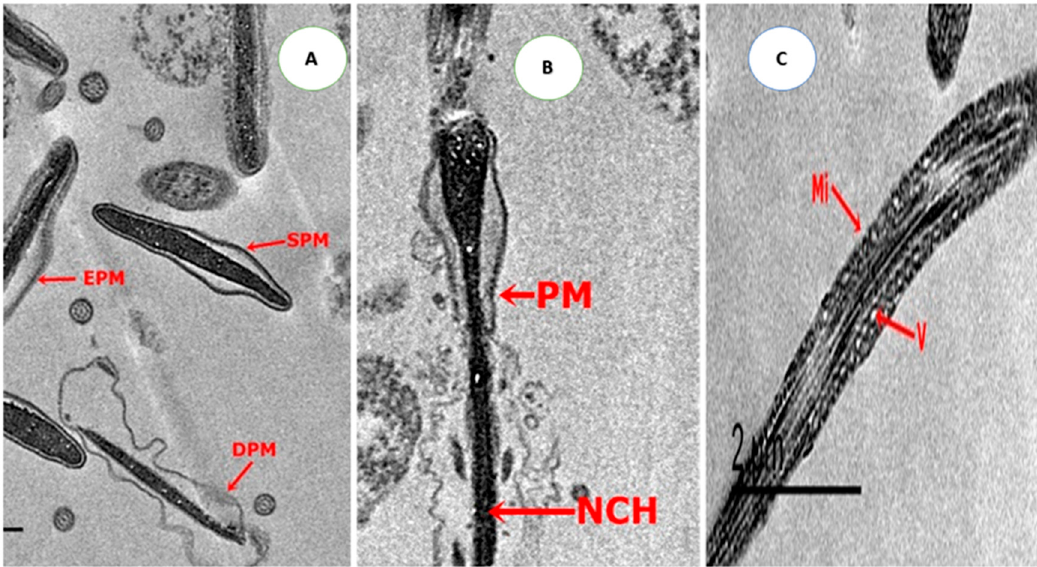
Figure 2. Transmission electron microscopic photomicrographs of sections of the rabbit sperm head in control, CU0.5, and CUNPs0.5 groups representing different stages of damage after freezing—thawing process. ( A ). The plasma membrane was slightly swollen (EPM) and damage in the plasma membrane (DPM); ( B ). A complete loss of PM, an abnormal nucleus with necrosis chromatin (NCH), damage of acrosomal cap (DAC), cell membrane and diffusion of acrosomal dense material into the previously formed space; ( C ). Abnormal mitochondrial sheath (Mi) appeared vacuolated (V) with narrowed membrane space and absence of cristae and cell membrane.